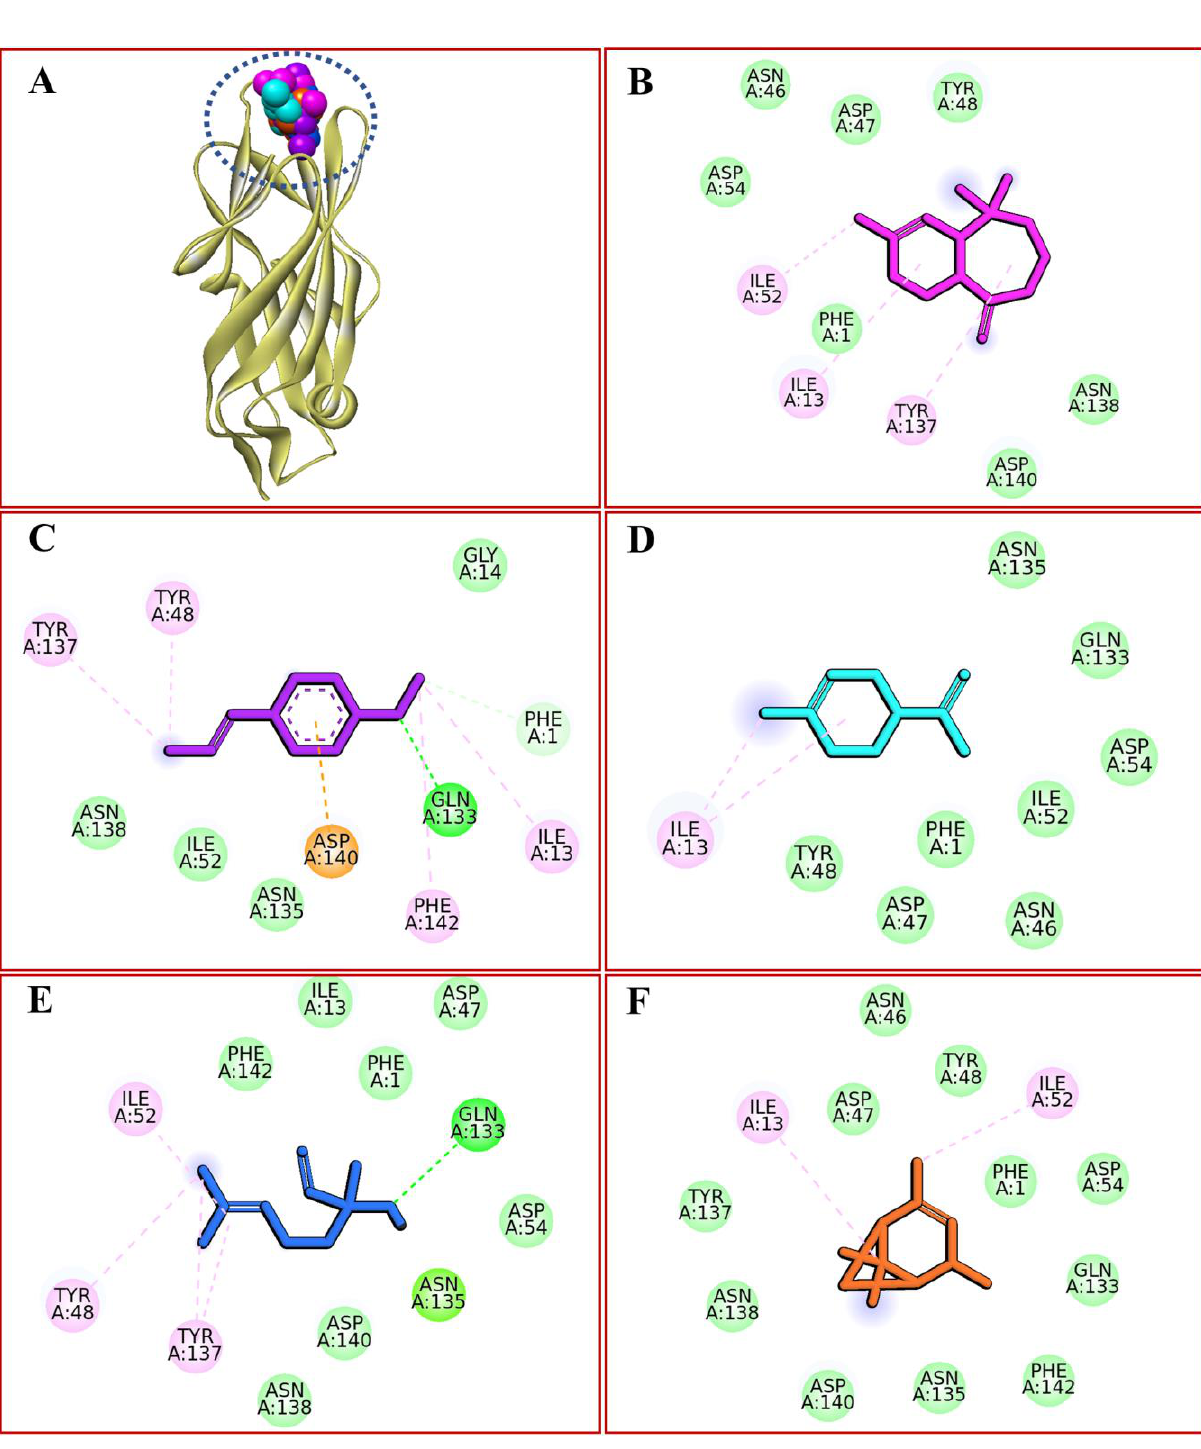
Figure 7. Intermolecular interactions of Pimpinella anisum L. essential oil components (shown as CPK style) with adhesin protein FimH of E. coli , depicted as ribbon ( A ); α -himachalene, shown as stick in pink colour ( B ); anethole, shown as stick in purple color ( C ); limonene, shown as stick in cyan color ( D ); linalool, shown as stick in blue color ( E ); trans -verbenol, shown as stick in brown color ( F ).